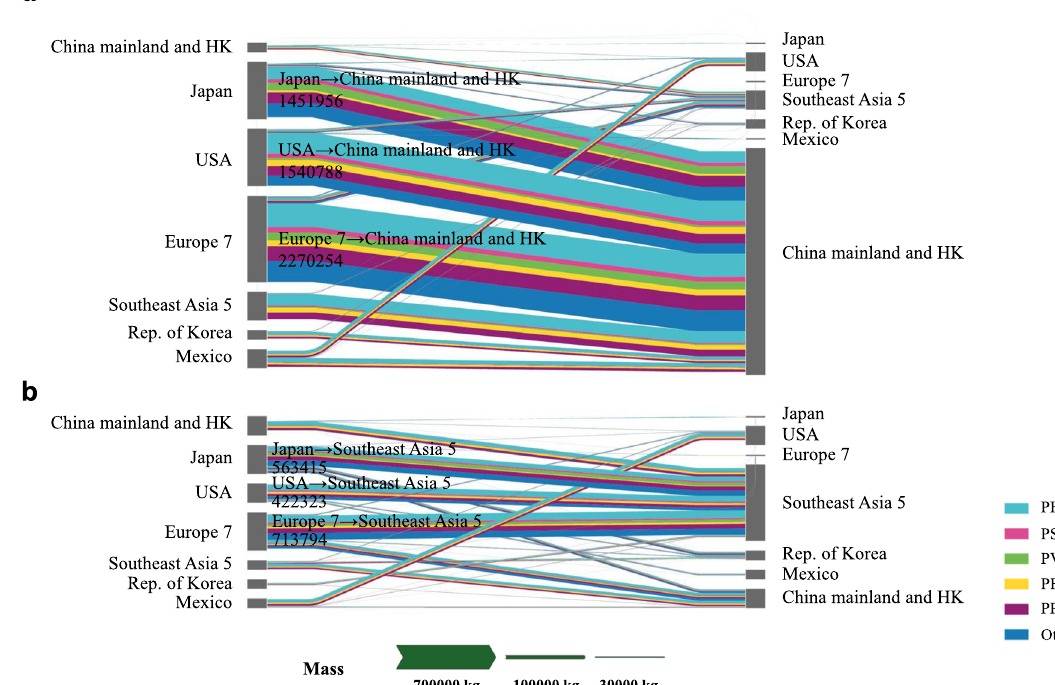
Fig. 1 The trade fl ows of six types of plastic waste under two scenarios. a presents the global trade fl ows of six types of plastic waste prior to the ban (Baseline Scenario), while b presents the fl ows subsequent to the ban (2018 Scenario). The unit of the fl ows is tons. The data source of a and b is shown in Supplementary Tables 1 and 2. The fl ows of six types in the Figure are based on estimation (Supplementary Table